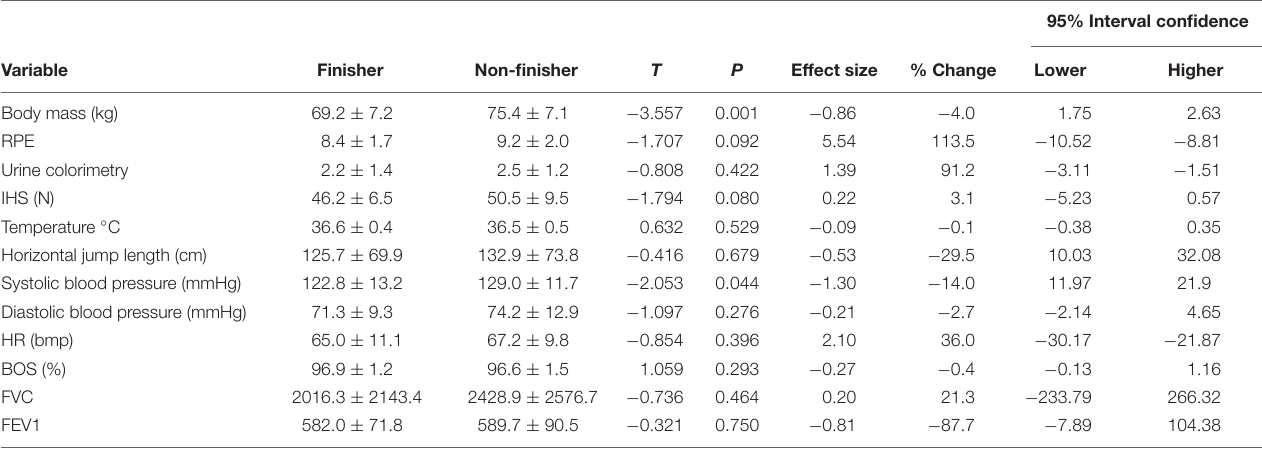
TABLE 1 | Differences between mountain ultra-endurance finishers and non-finishers in pre-race body mass and psychophysiological parameters.